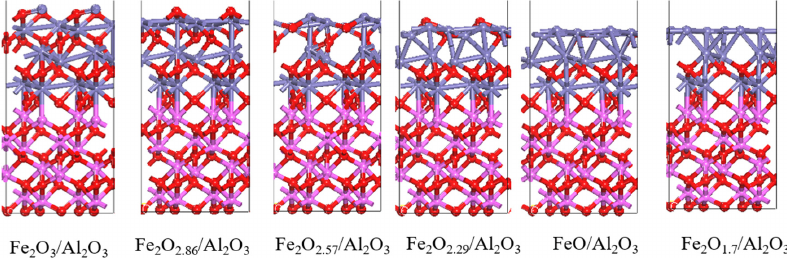
Figure 4. The stable configurations of the pure Fe 2 O 3 /Al 2 O 3 slab and a series of the reduced Fe 2 O 3 /Al 2 O 3 slabs.